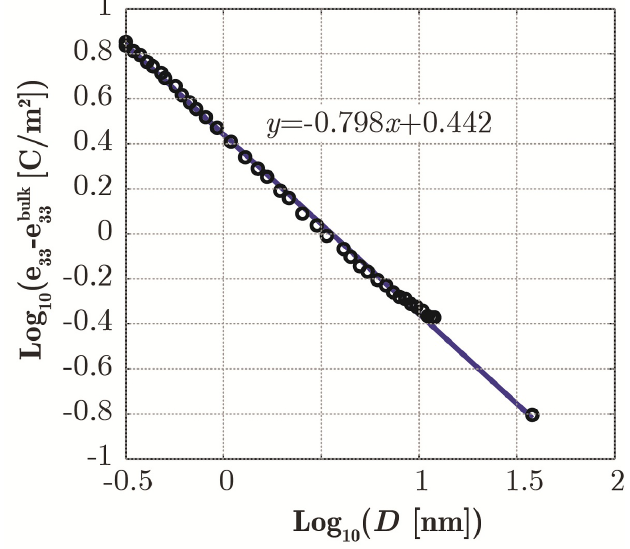
Figure 7. The agreement between data from [9,12] and the power-law fit for piezoelectric versus NW diameter ( β = − 0 . 798 ). Plot in log-log constant e 33